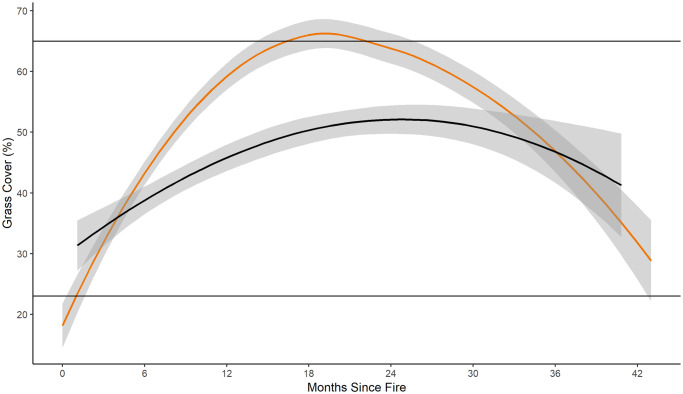
Percent grass cover.Percent grass cover for fire-only (orange) and pyric herbivory (black) treatments at all sites from 2014 to 2016. Shaded area indicates 95% confidence interval. Horizontal lines represent the minimum (~23%) and maximum (~65%) grass cover reported used for nesting by Tympanuchus spp. *Regression lines and confidence intervals generated using “loess” locally-weighted smoothing function.